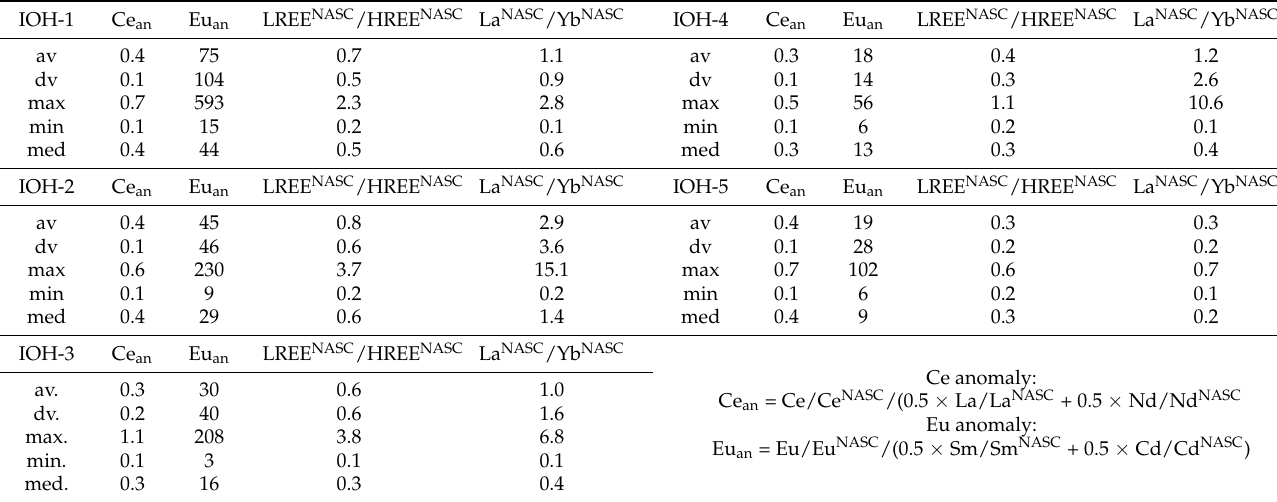
Table 3. REE data for IOH types of the Pobeda-1 hydrothermal